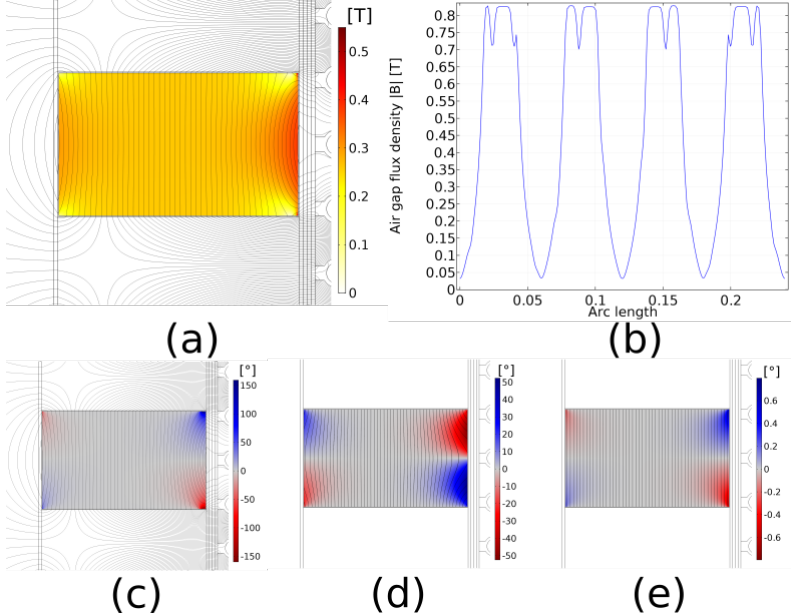
Figure 3. Different components and directions of B , H and M from B = µ 0 ( H + M ) of the linear default case. ( a , b ) shows the magnetic flux density magnitude in the PMs and air gap, respectively. ( c – e ) shows the inclination angles of the magnetic flux density B , magnetic field strength H and magnetization M , respectively.